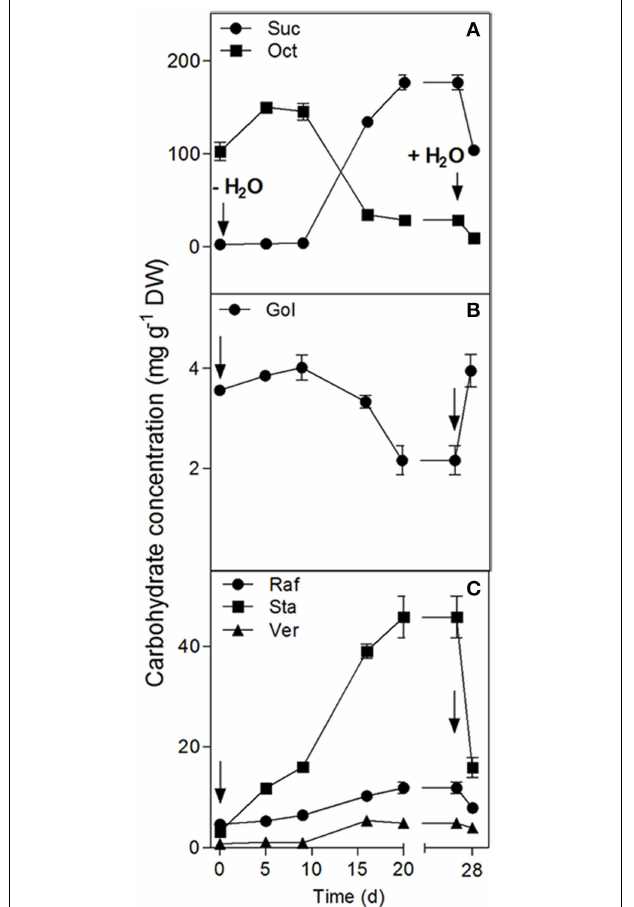
FIGURE 2 | Changes in the water soluble carbohydrate concentrations in the leaves of C. plantagineum plants subjected to a 20d water deficit stress. Plants were then held in a dried state for 7d and water deficit was alleviated by re-watering the plants. WCSs were analyzed by HPLC-PAD using MA1 and BC100 columns. Error bars indicate the standard error between the mean of six replicates. Suc, sucrose; Oct, octulose; Gol, galactinol; Raf, raffinose; Sta, stachyose; Ver,